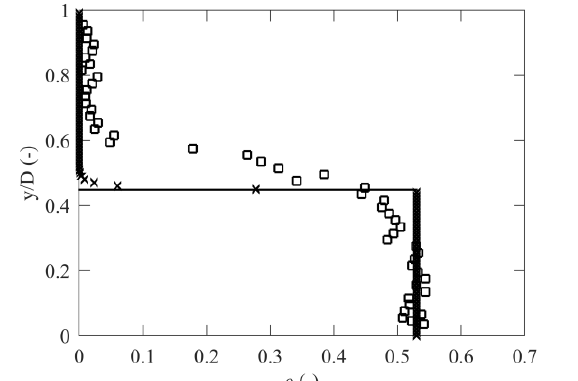
Fig. 5. Distribution of granular concentration at velocity slightly above deposition limit for flow of SP090 slurry ( C vd,max = 0.26) at pipe inclination of -25 deg, V m = 0.9 m.s -1 , C vd = 0.048 . Legend: square = experiment, x = model